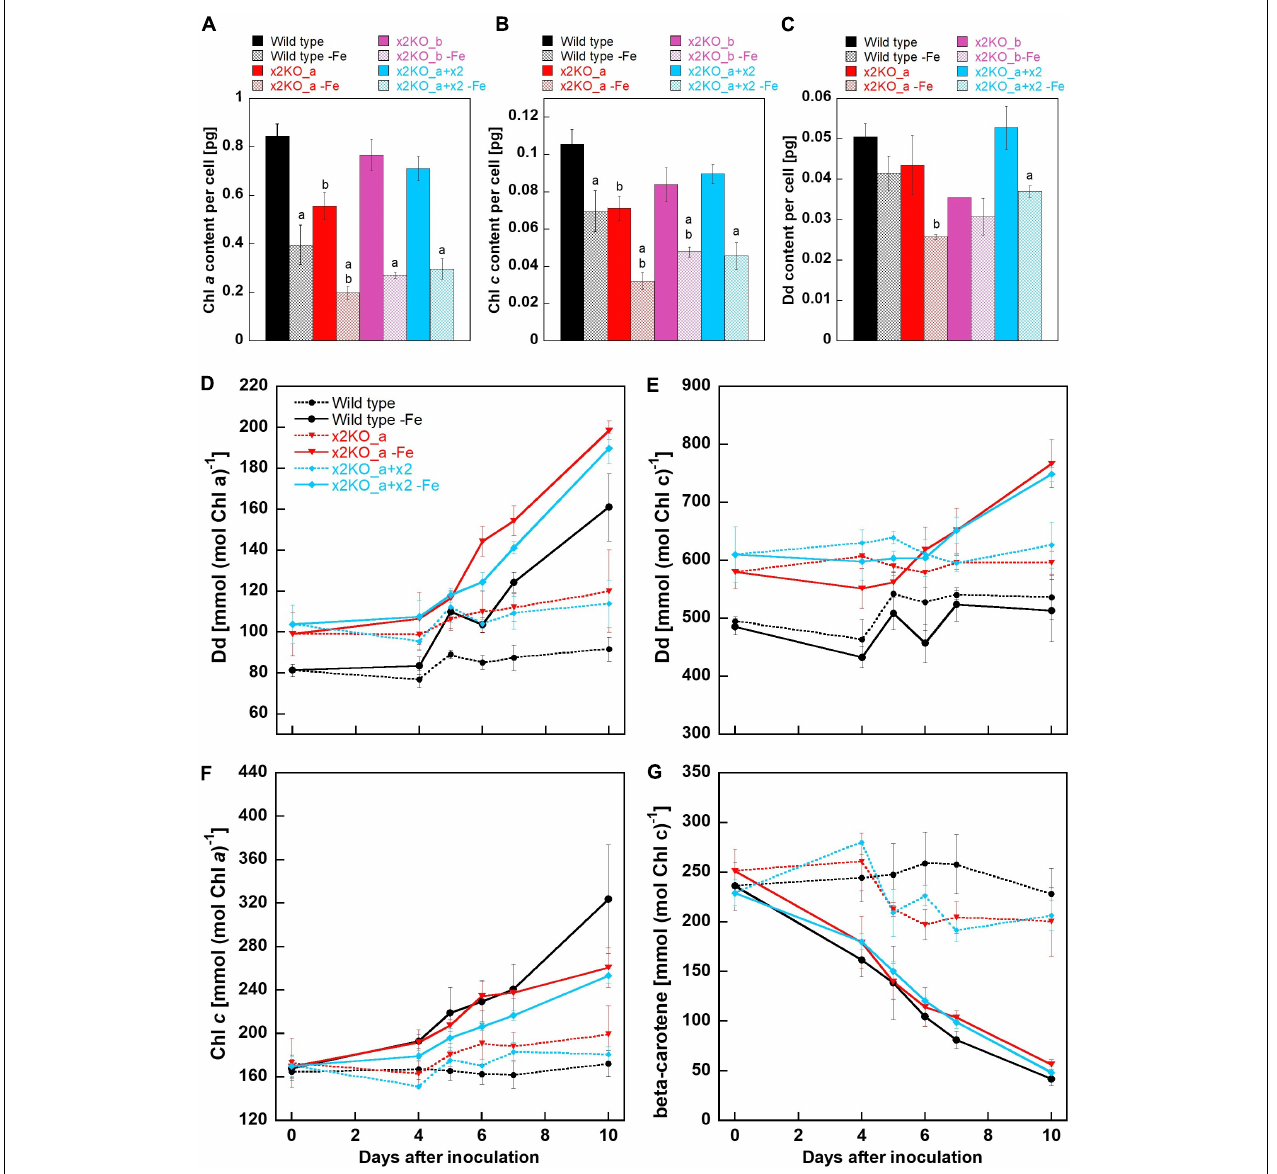
FIGURE 4 | Pigment analysis of Phaeodactylum tricornutum wild type and mutant strains within 10 days after transfer to an iron-depleted medium. (A) Chl a amount per cell. (B) Chl c amount per cell. (C) Dd amount per cell. Mean values are derived from three to seven independent replicates except for Dd content/cell of the x2KO_b line (one replicate) and of the x2KO_b-Fe line (two replicates). SE is given. Statistical significance was tested by a two-tailed unpaired Student’s T -test (except for the x2KO_b and x2KO_b-Fe lines in C): (a) statistically significant in iron-replete vs. iron-depleted strain; (b) statistically significant in the respective mutant vs. the wild type exposed to the same iron treatment. (D) Dd content normalized to Chl a . (E) Dd content normalized to Chl c . (F) Chl c content normalized to Chl a . (G) β -carotene content normalized to Chl c . Mean values are derived from three to seven independent replicates. SE is